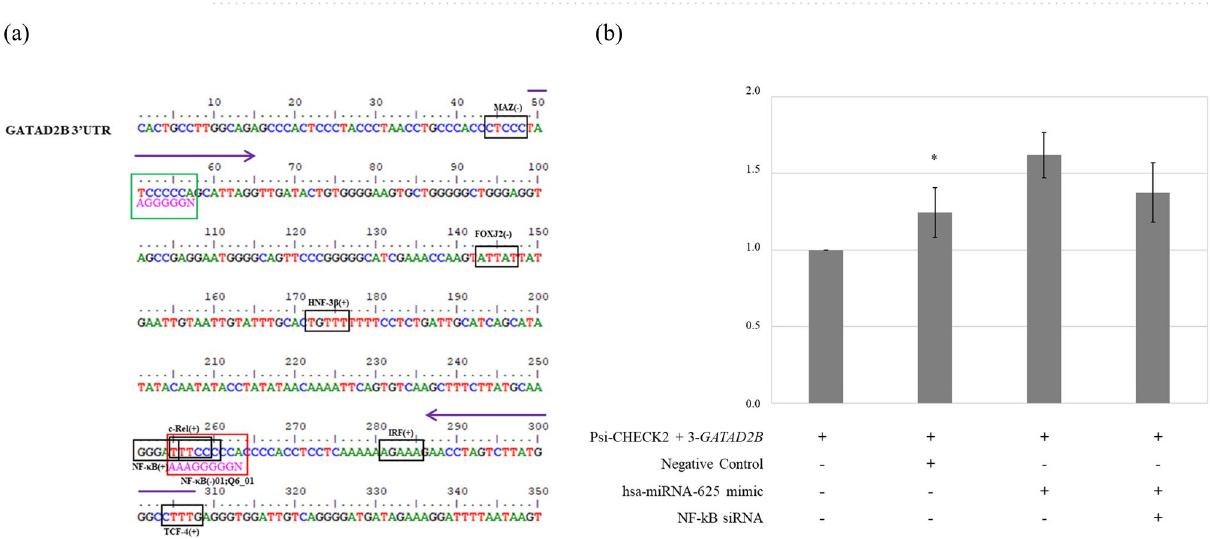
Figure 4. ( a ) Prediction of transcription factor binding sites near hsa-miRNA-625-5p 9mer and 7mer-A1 binding sites in the 3 ′ UTR of GATAD2B. The predicted transcription factors are in black boxes with name on the top. The hsa-miRNA-625-5p 7mer-A binding site is in the green box with sequence AGG GGG N, and the 9mer binding site is in the red box with sequence AAA GGG GGN. The arrows show the location of GATAD2B #3 forward and reverse primers. ( b ) Luciferase analysis of GATAD2B #3 co-transfected with hsa-miRNA-625-5p and NF-κB . All the bars in the graphs were plotted as the mean ± SD. The student’s t -test was used to determine the significance of the results. Asterisks indicate the significance of the results. (*P <